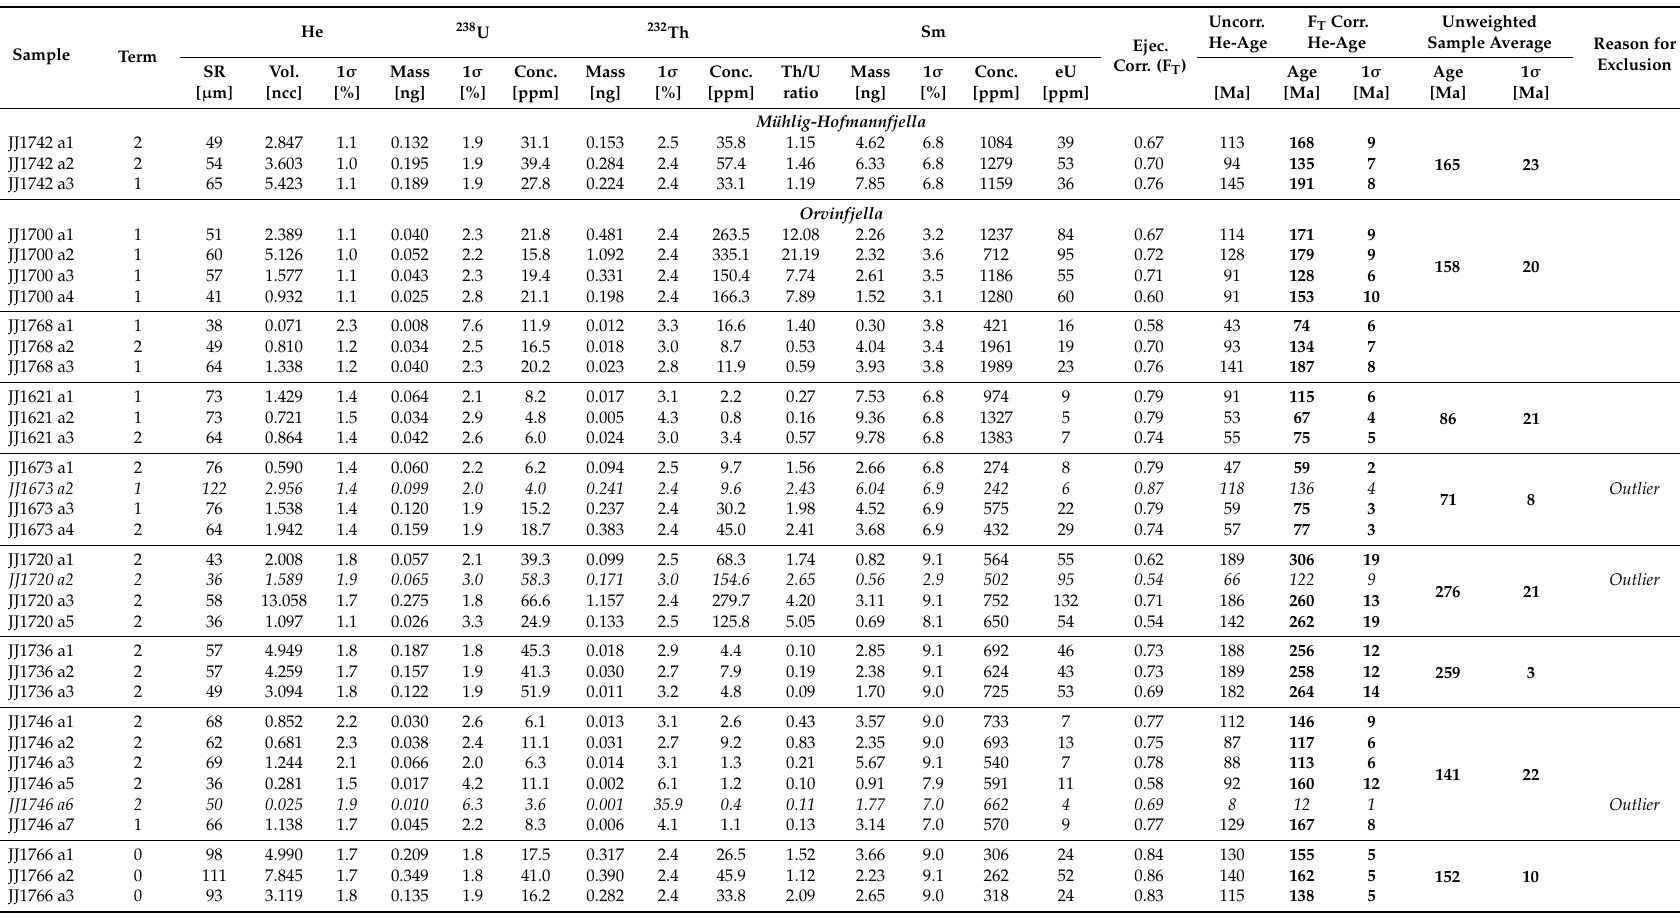
Table A2. Apatite and zircon (U-Th)/He analyses.; Excluded analyses are marked in italic. The reason for exclusion is given in the last column of the table.